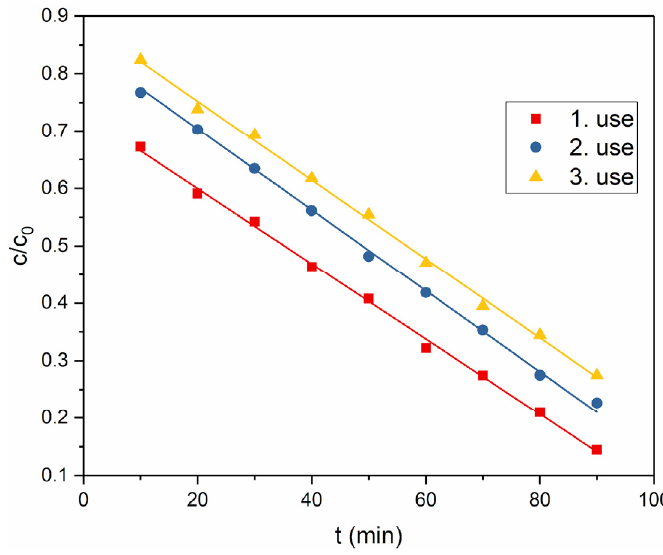
Figure 7. Reusability experiments with sample A ( γ (TiO 2 ) = 0.25 g/L). SEM image of sample A after repeated use is shown in Figure 8. While there is some damage to the particles, it is minor and likely the result of drying and scraping the sample after each use rather than the photocatalytic experiments themselves.